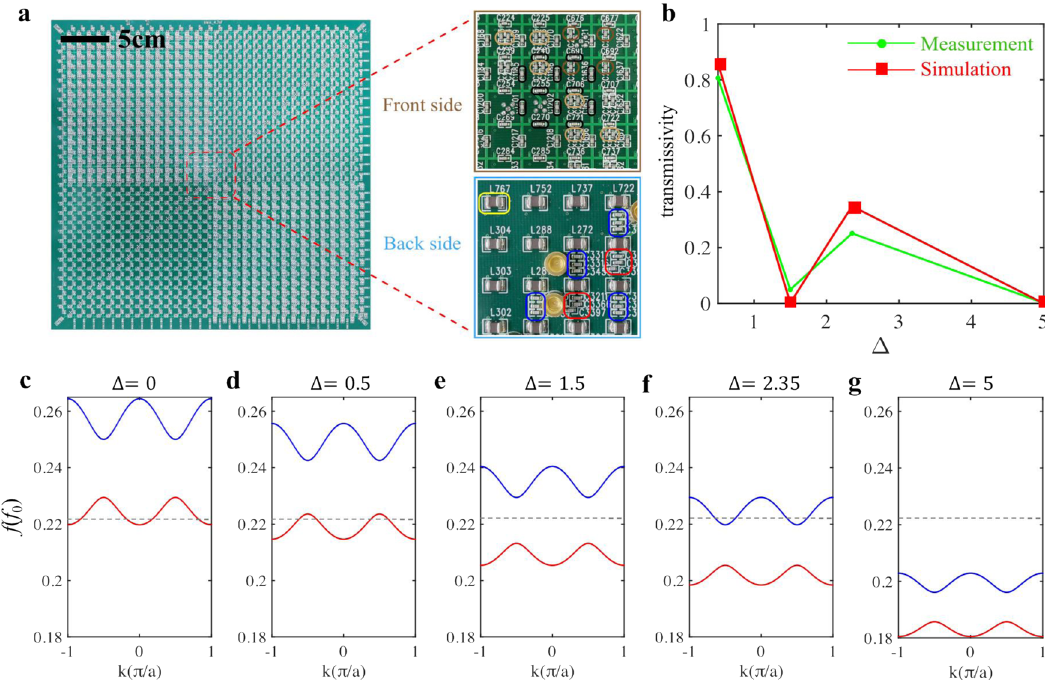
Fig. 3 The results for observing interaction-induced Klein tunneling of doublons in electric circuits. a The image of the fabricated circuit for simulating the Klein tunneling of doublons. The dark and light brown frames in the front side of the sample enclose the grounding capacitors related to the potential step in the fi rst and second/third quadrants, respectively. The black frames in the front side of the sample mark C . The red, blue and yellow circles enclose the grounding capacitor C U , C U 0 on the main and fi rst lateral diagonals and grounding inductor L g , respectively. The value of C, C U , C U 0 and L g are taken as 1, 15, 12 nF and 3.3 μ H, respectively. b The calculated and measured transmissivities with Δ ¼ 0 : 5, Δ ¼ 1 : 5, Δ ¼ 2 : 35 and Δ ¼ 5, respectively. The error bar, which corresponds to the difference for the measured transmission at many times, is much smaller than the corresponding data points. c – g show the calculated circuit dispersions of doublons with Δ ¼ 0 : 0, Δ ¼ 0 : 5, Δ ¼ 1 : 5, Δ ¼ 2 : 35 and Δ ¼ 5, respectively, and the dash lines mark the excitation